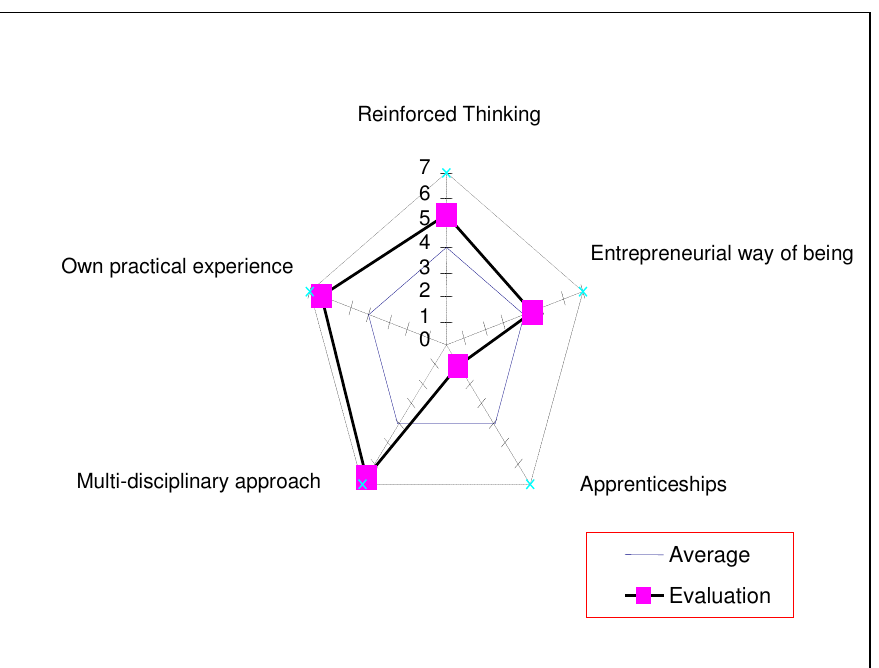
Figure 7: Assessment results for the facilitator